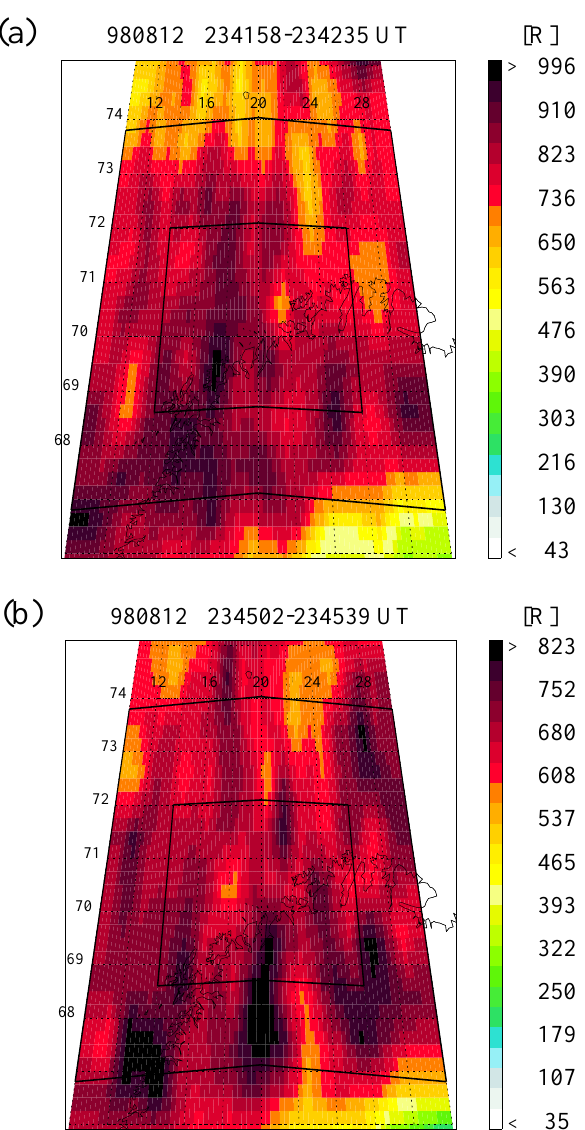
Fig. 10. The UVI-LBHL images for the two time steps of ( a ) 2341:58-2342:35 UT and ( b ) 23:45:02–23:45:39 UT on 12 August 1998. The inner black box drawn on top of the images corresponds to the STARE FOV, while the outer box matches the PIXIE resolu- tion of ∼